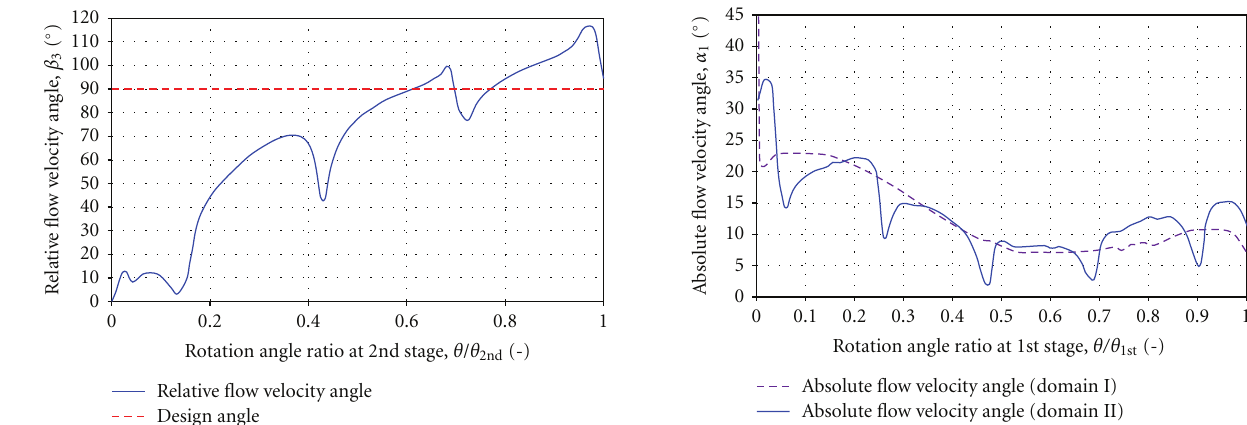
Figure 18: Relative flow velocity angles of 2nd runner stage entrance along the normalized rotation sector at design conditions.